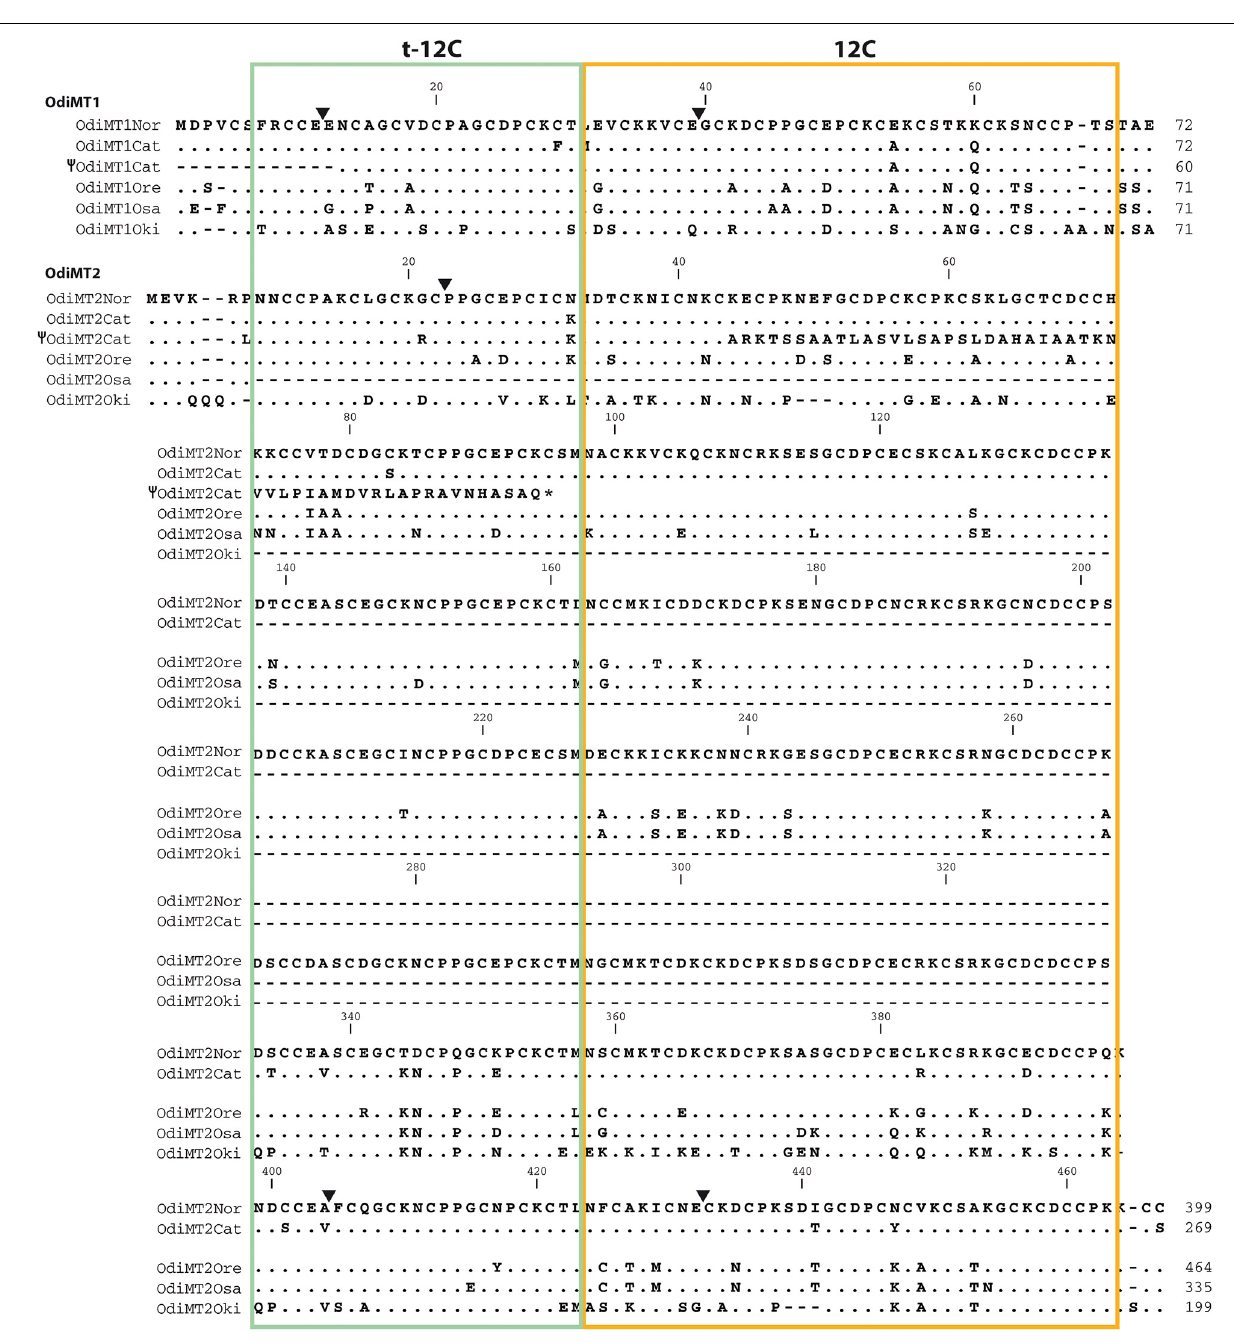
FIGURE 4 | Amino acid alignments of OdiMT1 and OdiMT2 variants form Norwegian (NOR), Catalonian (CAT), Oregonian (ORE), Osaka (OSA), and Okinawa (OKI) O. dioica populations. Norwegian sequences are used as reference; dots and dashes indicate amino acid identity and gaps, respectively. Black arrowheads indicate the intron positions relative to the amino acid sequences. The sequences of two hypothetical OdiMT pseudogenes –i.e., (cid:57) OdiMT1 CAT , lacking the first 12 residues, and (cid:57) OdiMT2 CAT , with a premature stop codon (*)– are also included. Trimmed 12-Cys domains (green box) and full-length 12-Cys domains (orange box) at the N- and C-terminal regions of the RU, respectively, are